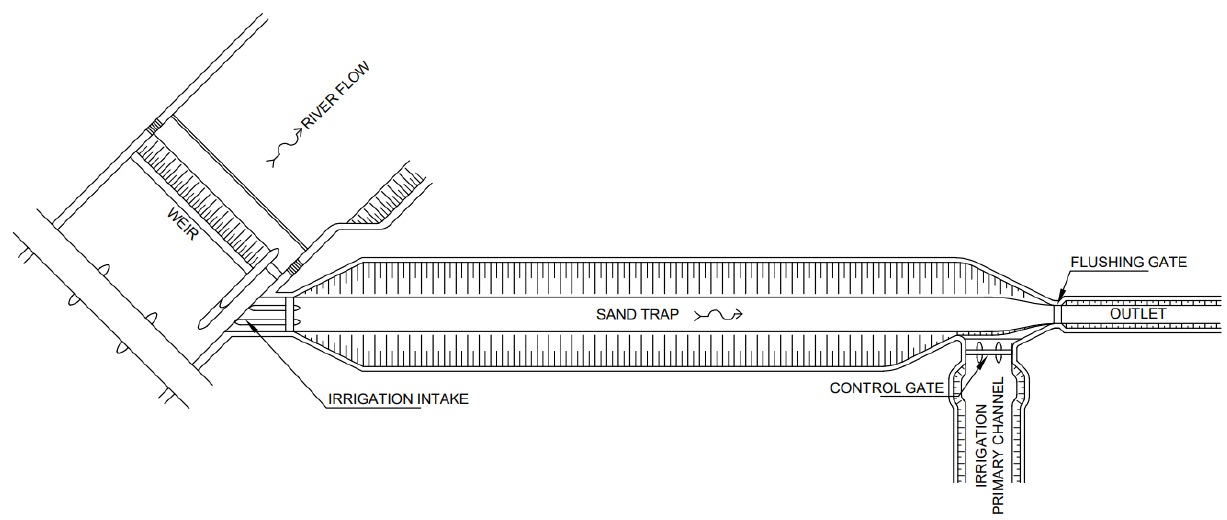
Figure 1. Sand trap layout in an irrigation network. A sand trap is positioned downstream of the irrigation intake and is equipped with a flushing gate. Its function is to deposit sediment entering the irrigation network before it enters the primary irrigation channel.